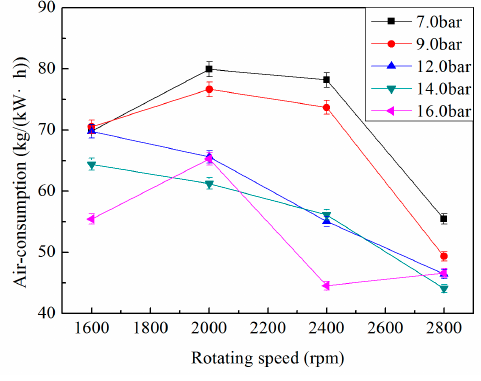
Figure 11. Air-consumption versus rotating speed.